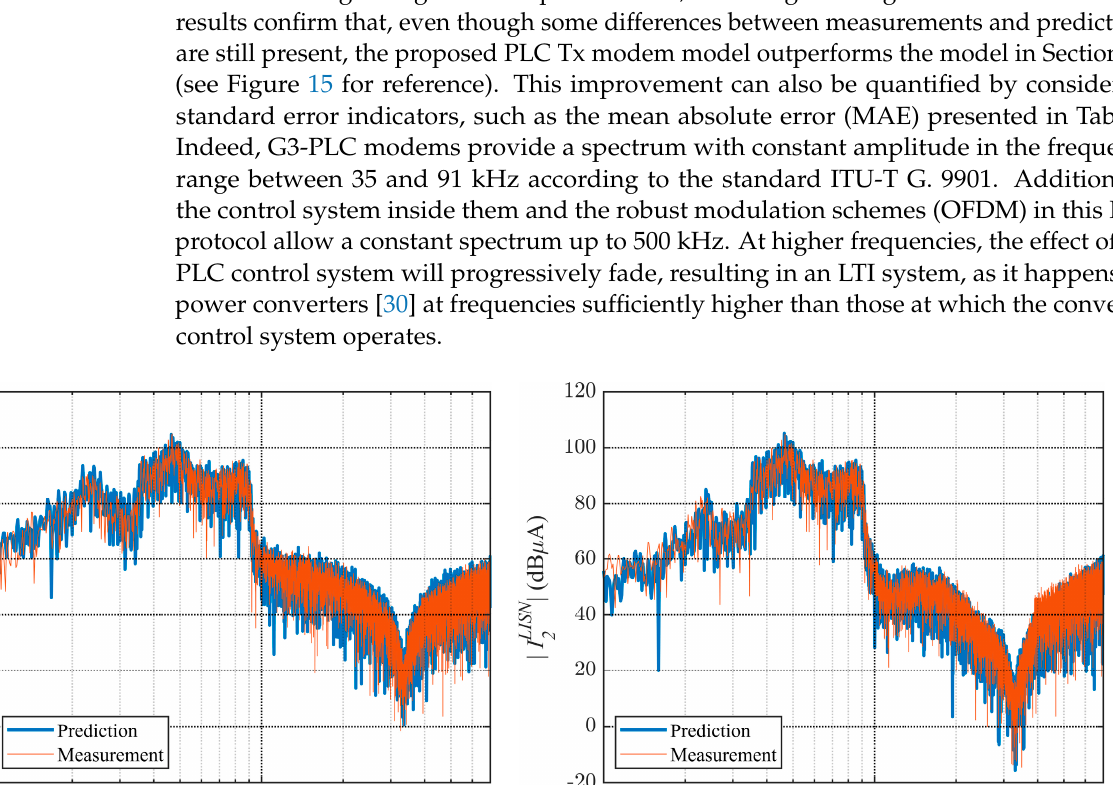
Figure 17. Currents ( a ) I LISN data in test case #1 (with LISN B1). The PLC Tx modem is represented according to Section 5.